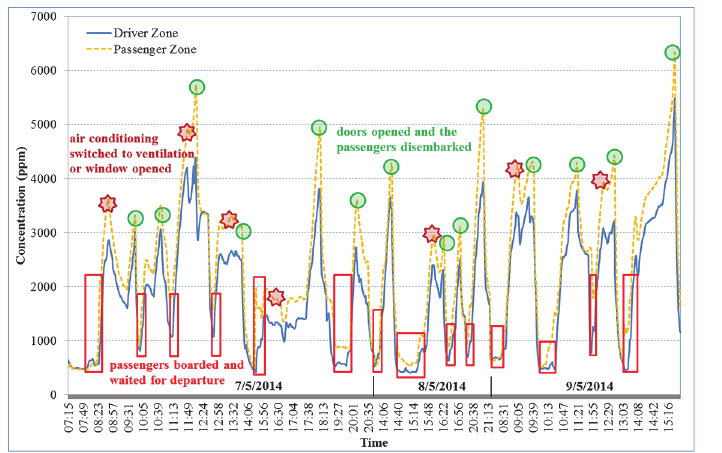
Fig 1. CO 2 concentrations in the tour bus A as a function of